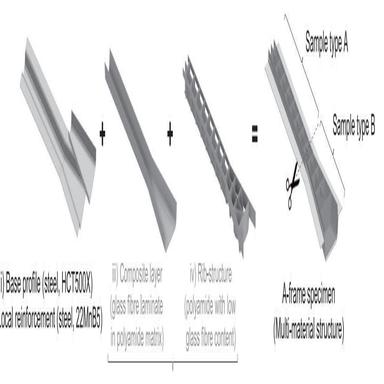
Specimens typical for automotive A-frames served as samples for the experimental shredding study. The structural components and materials are first depicted separately (i to iv) and then combined into a multi-material structure. The cutting line for preparing samples of type A and type B from A-frame specimens is indicated.